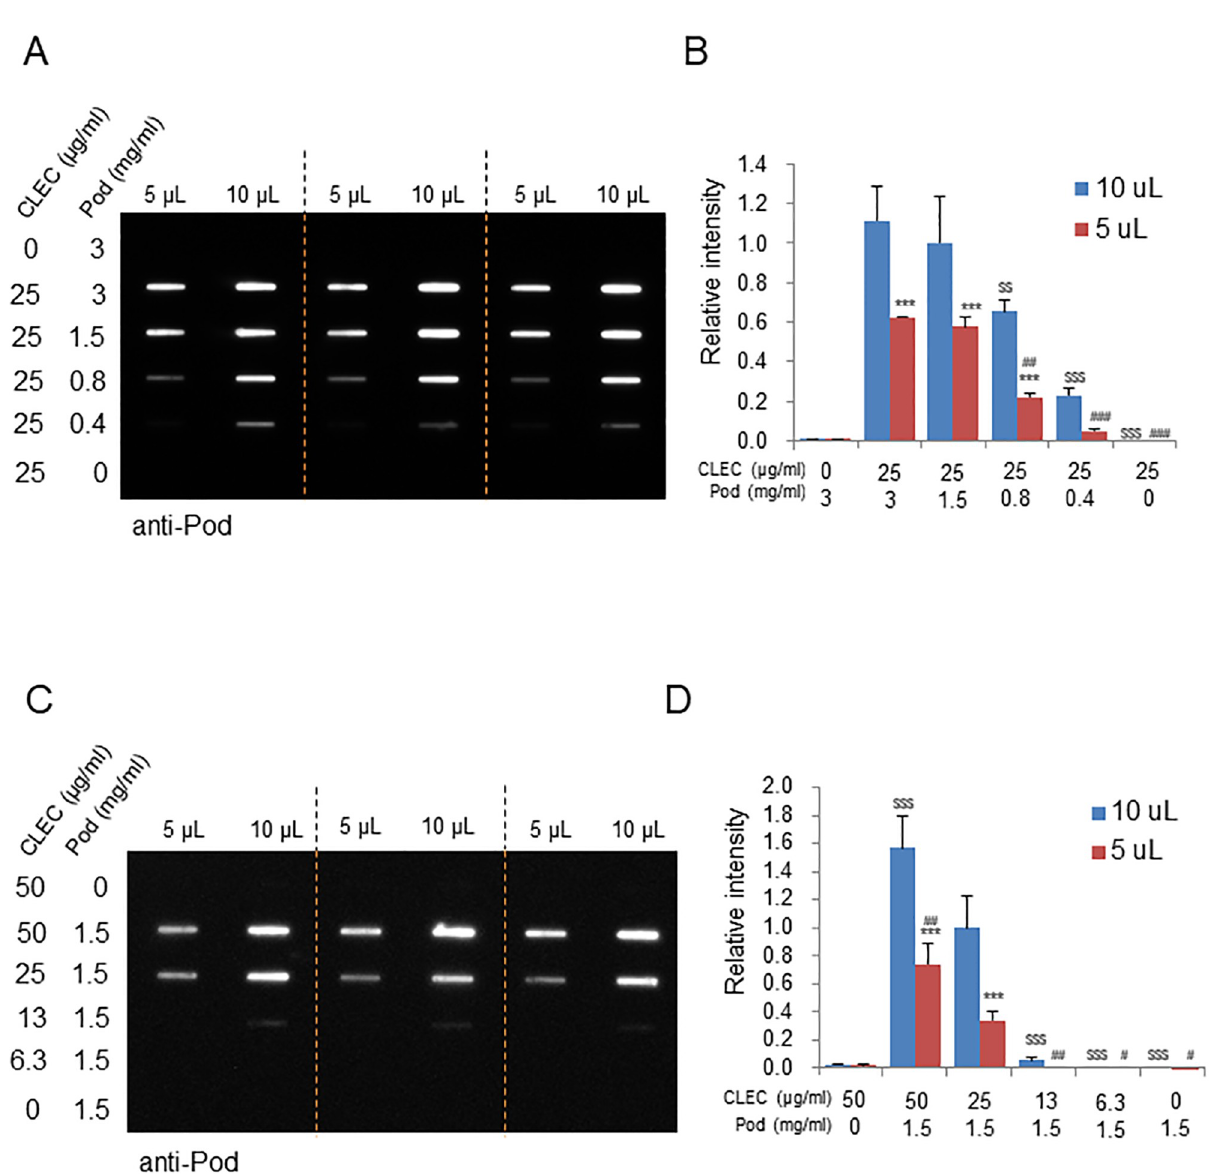
Fig 4. Slot blot analysis of the concentration dependence of podoplanin sedimentation by Fc-CLEC-2 from pod-HeLa cell lysates. (A and C) Slot blot detection of podoplanin-Fc-CLEC-2 complex formation. Acid-elution fractions were obtained from complexes formed with the indicated concentrations of Fc-CLEC-2 and pod-HeLa lysates, as in Fig 3. Either 5 μ L or 10 μ L of acid-eluted fractions were diluted with PBS to 200 μ L, slot- blotted onto PVDF membranes, and stained with an anti-podoplanin antibody. (B and D) Densitometric analysis of the slot bands. The intensity of each slot was normalized to the value obtained at 10 μ L loading, from a reaction of 25 μ g/mL Fc-CLEC-2 and 1.5 mg/mL pod-HeLa lysate (‘standard combination’). Weak slot signal detected from Fc-CLEC-2 (50 μ g/mL) alone (A and B) was due to the cross-reaction of secondary antibody (anti-Rat IgG) with the Fc portion (human sequence) of Fc-CLEC-2. Experiments were performed in triplicate, and the data on the bar chart are expressed as mean ± SD. The statistical significances are noted as follows: ��� , P < 0.001 with respect to 10 μ L blot in each respective Fc-CLEC and pod-HeLa lysate combination; $ $, P < 0.01, $ $ $, P < 0.001, with respect to the ‘standard combination’ for 10 μ L loading series; #, P < 0.01, ###, P < 0.001, with respect to the ‘standard combination’ for 5 μ L loading series. Data shown are a representative result from at least two independent experiments with similar